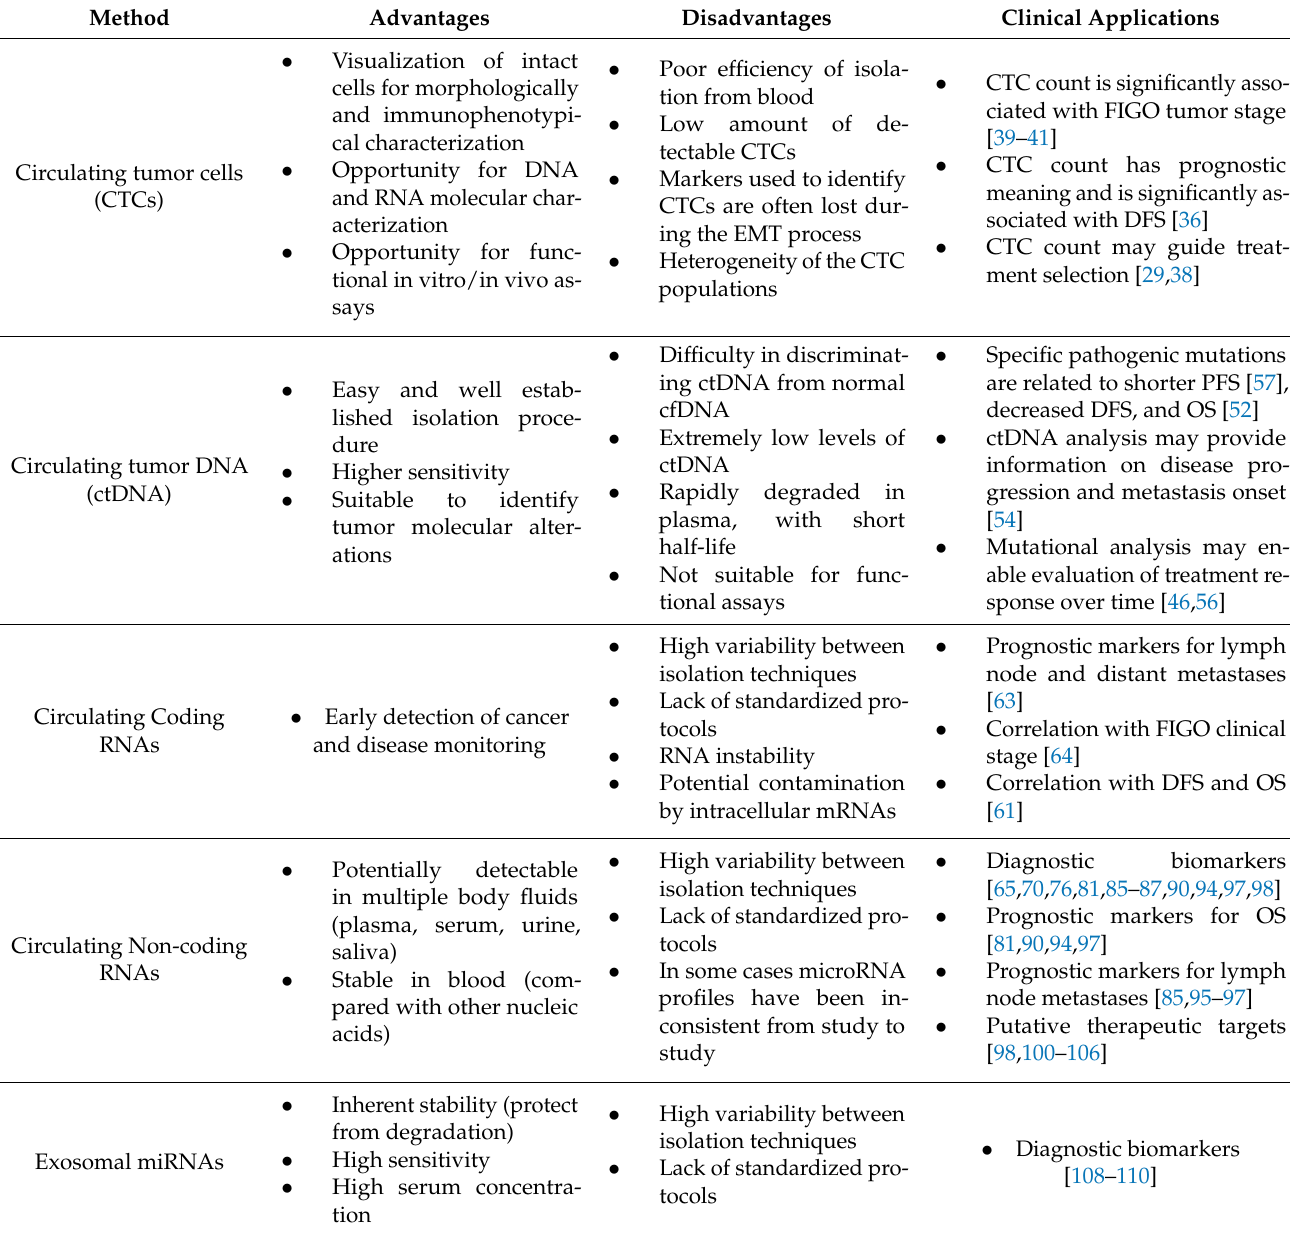
Table 4. Pros and Cons of liquid biopsy techniques applied to